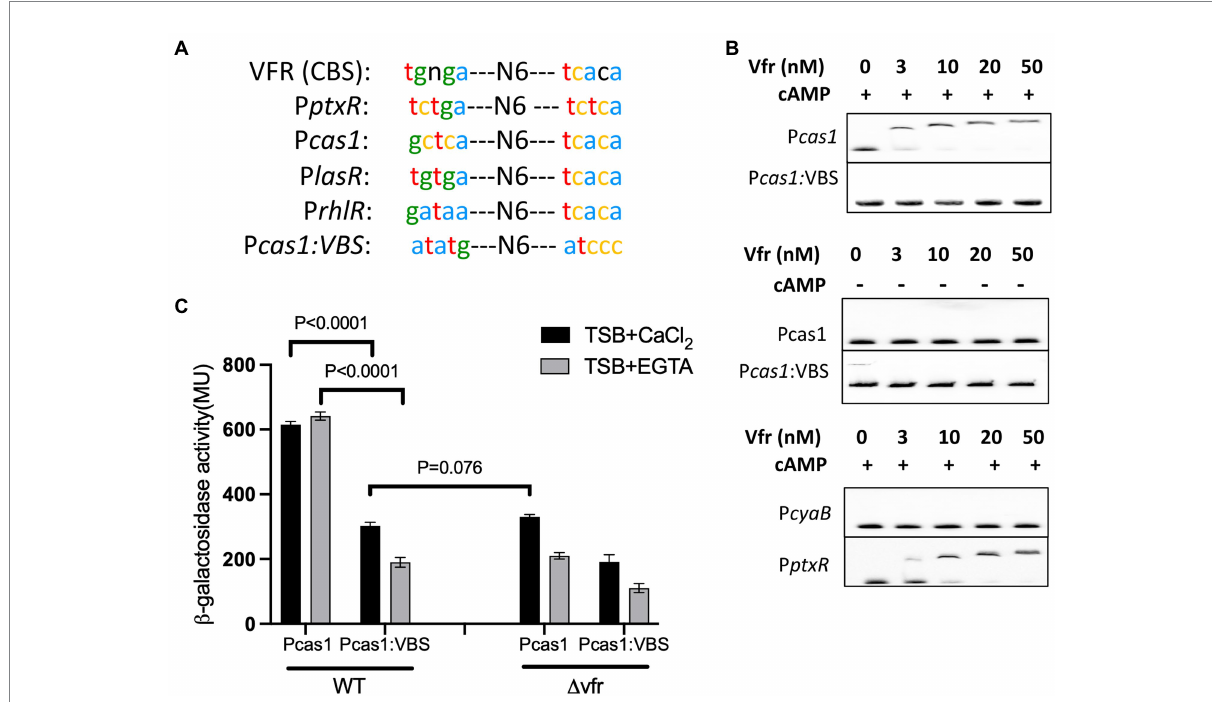
FIGURE 2 Vfr directly regulates the CRISPR-Cas system via a cAMP-dependent pathway. (A) The Vfr-binding consensus binding site [Vfr (CBS)] in P. aeruginosa and the Vfr binding sites in the promoter region of selected Vfr-regulated gene, ptxR , lasR , and rhlR share similarities with that of the cas1 promoter (P cas1 ). The bottom sequence is an altered P cas1 Vfr binding sequence (Pcas1:VBS), which was generated to investigate Vfr binding and regulation of cas1 . (B) EMSA analysis of Vfr with the cas1 promoter and its derivative Pcas1 (VBS) with an altered Vfr binding site. The probes of cyaB and ptxR promoter were used as negative and positive controls, respectively. Different Vfr concentrations were used as indicated with or without 10 μ M cAMP. (C) Expression of the P cas1 promoter construct composed of intact and altered VBS-binding sites in WT and vfr mutant grown in TSB + CaCl 2 and TSB + EGTA. Data shown are the mean ± SD ( n = 6). Statistical analysis was conducted by student’s t -test with a p value of < 0.05 is considered